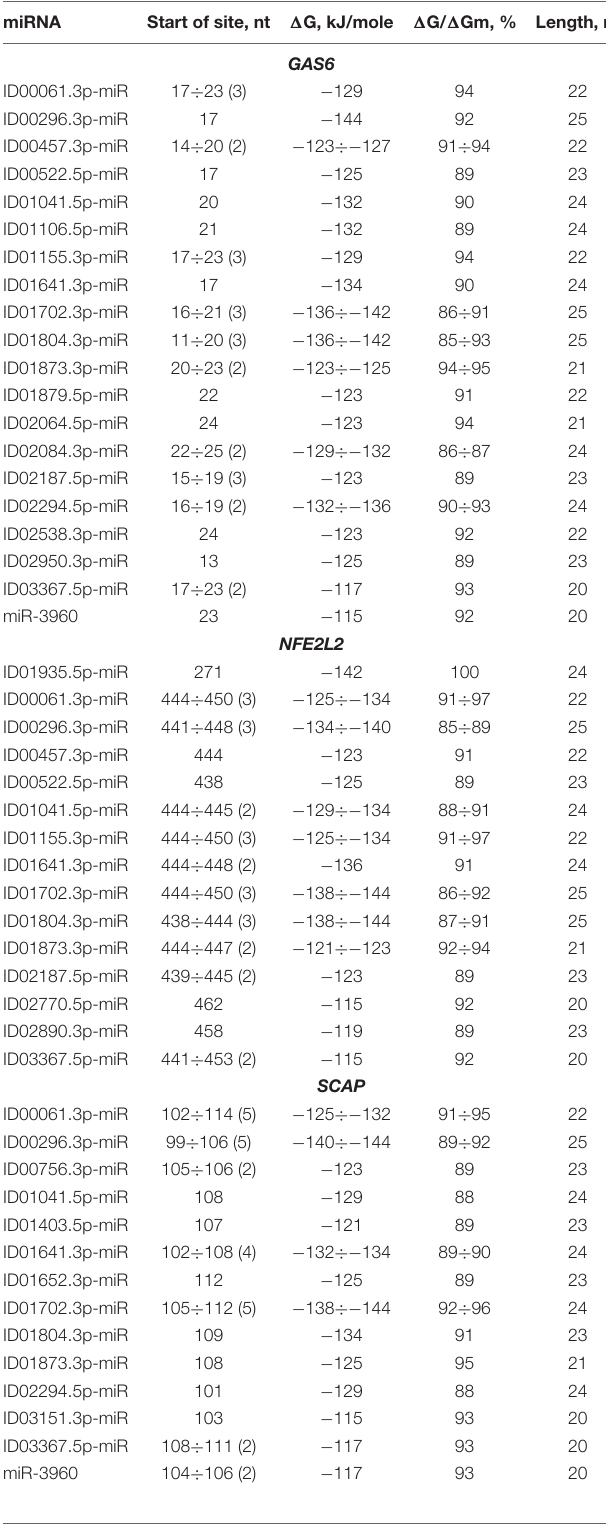
TABLE 1 | Characteristics of miRNAs interaction in the 5 (cid:48) UTR of mRNA of GAS6, NFE2L2, and SCAP